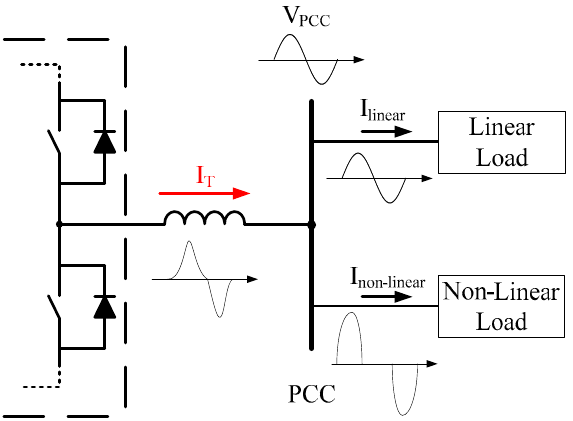
Figure 11. The current waveforms under the compensated nonlinear load condition.